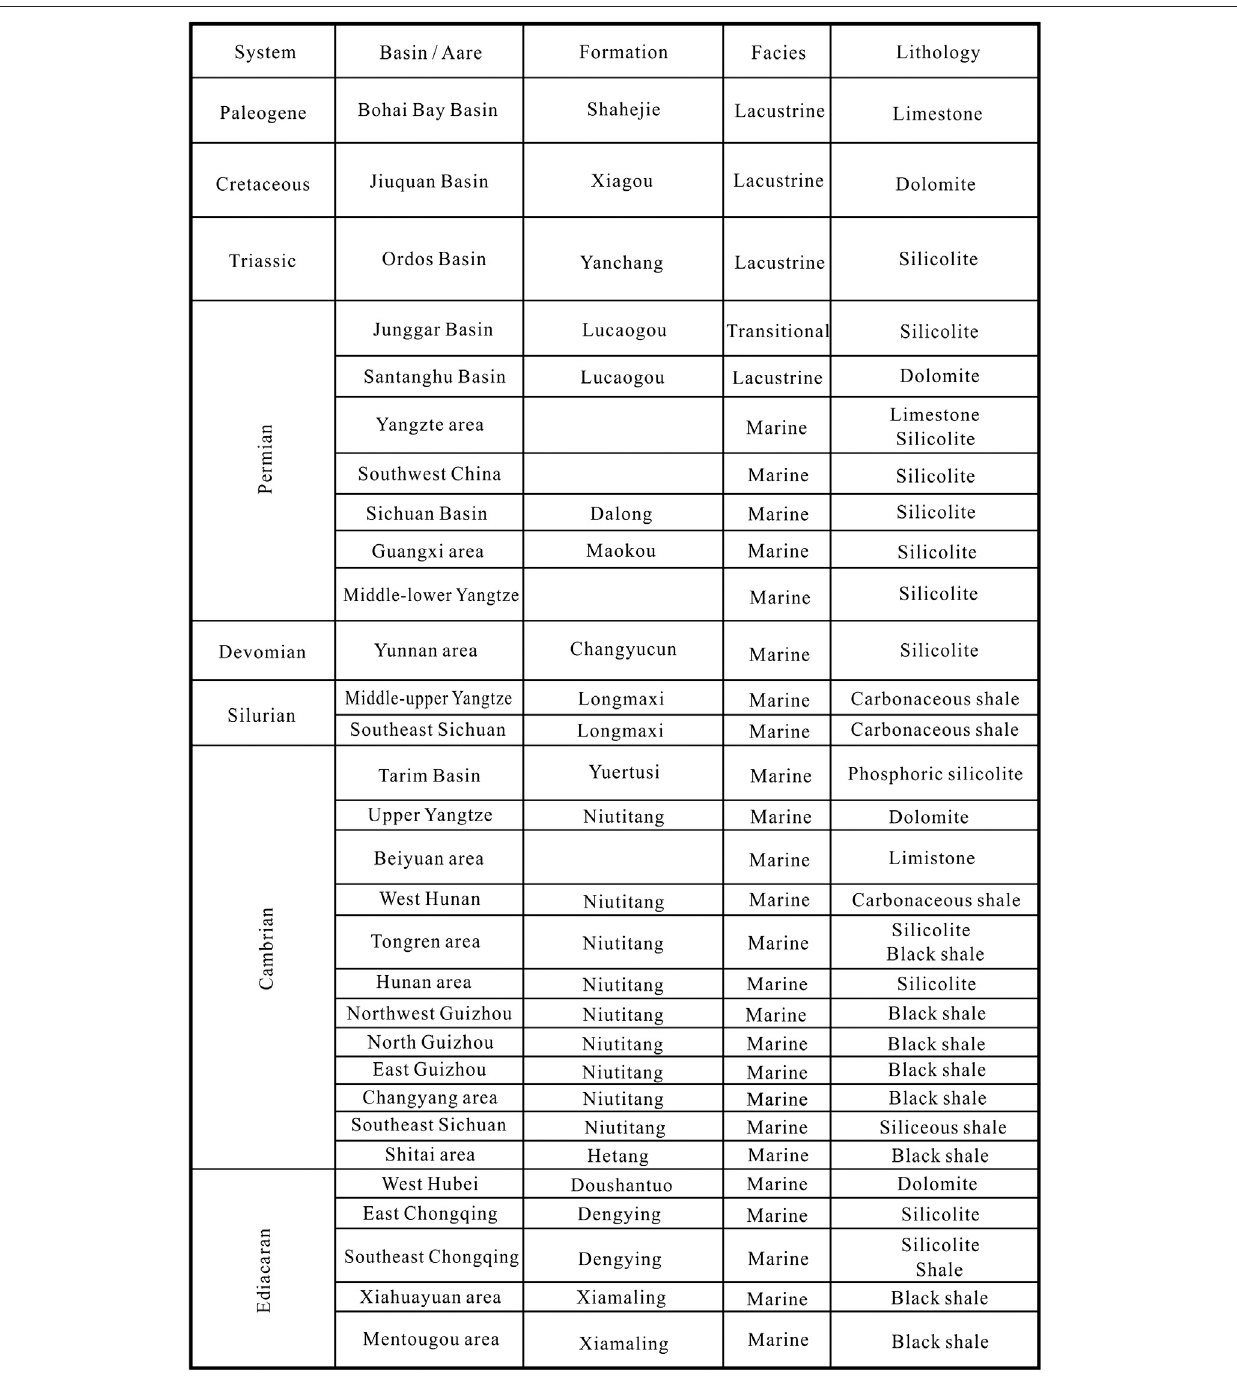
Frontiers in Earth Science |